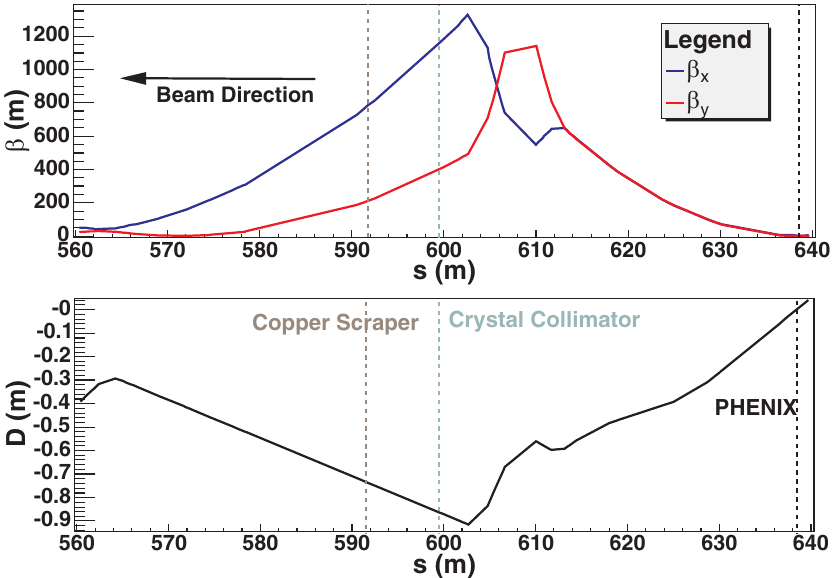
(cid:4) 1 m . PHENIX